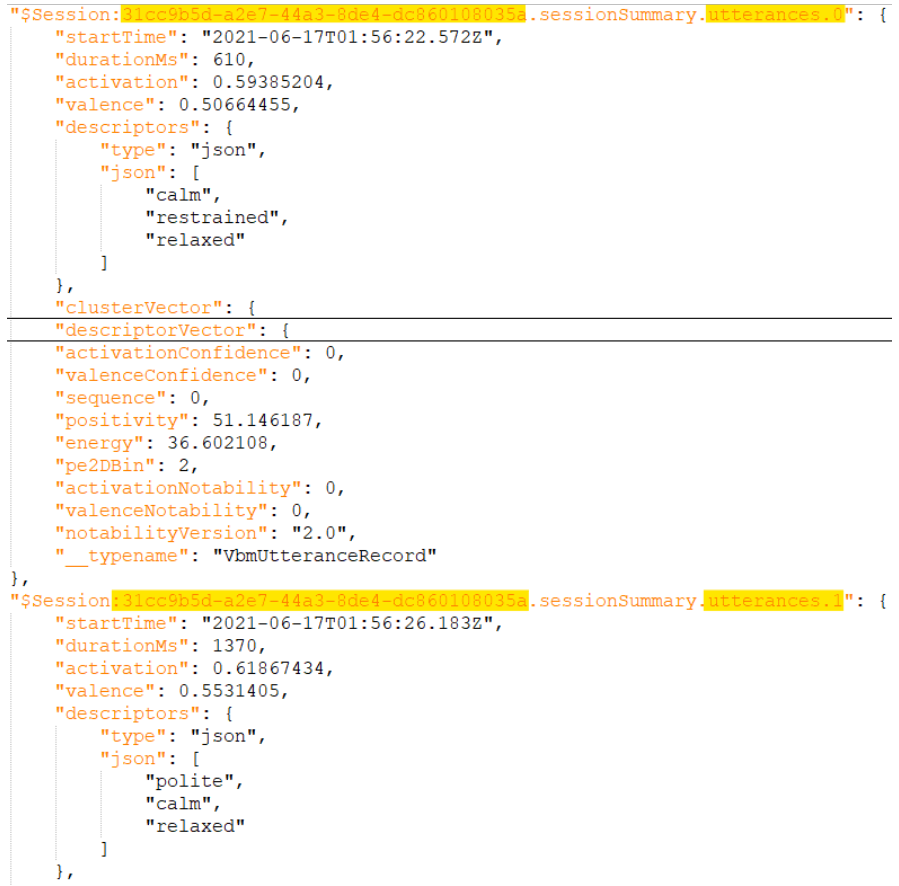
Figure 10. Results for the first two voice samples of a Tone Analysis session for the Amazon Halo device